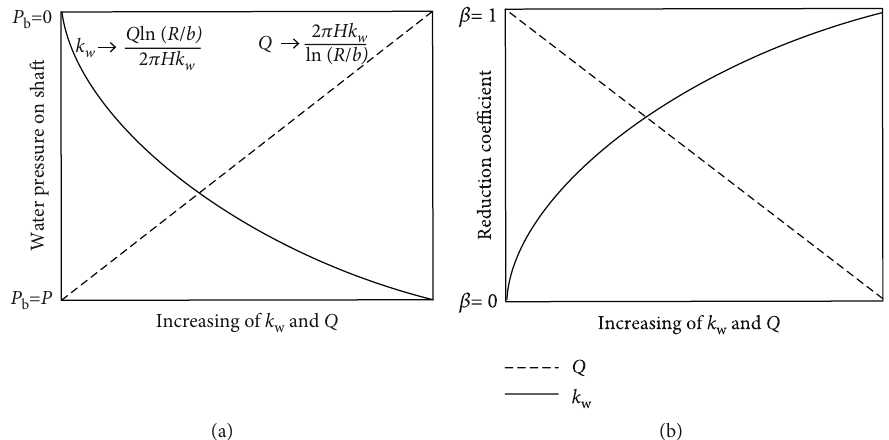
Figure 2: Schematic diagram of the evolution of shaft water pressure and reduction coe ffi cient: (a) evolution of P evolution of β with k